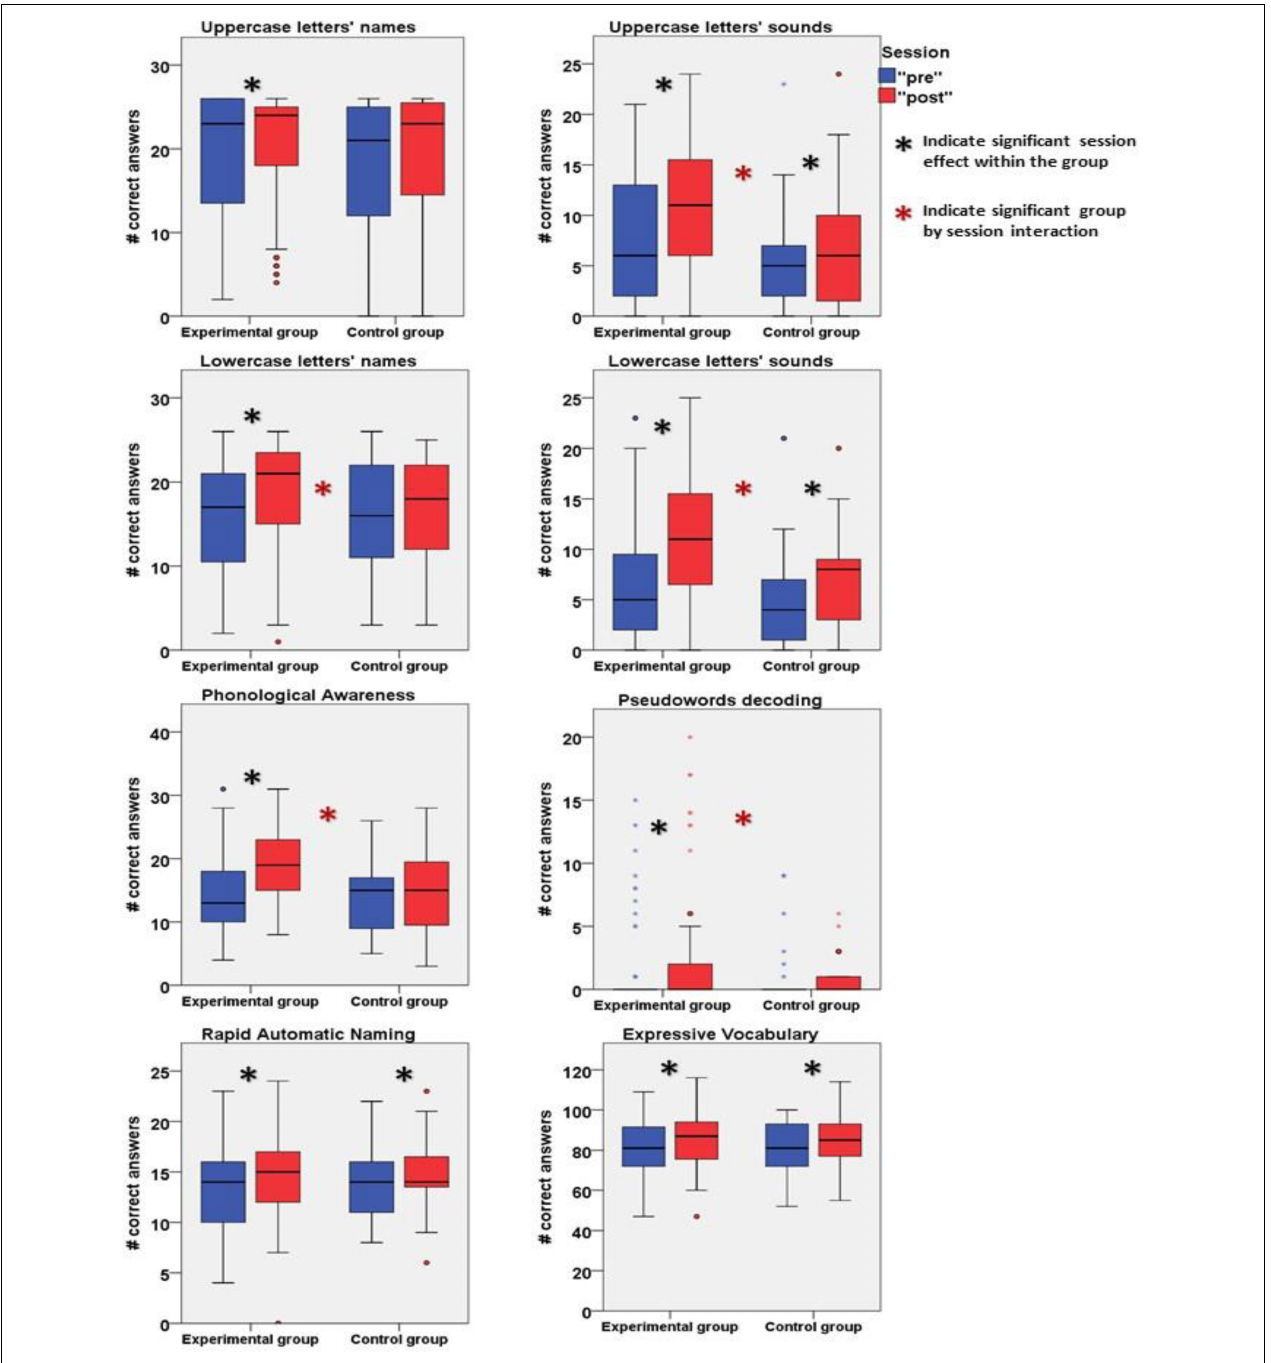
FIGURE 3 | Experimental and control groups’ results of “pre” and “post” measurements.